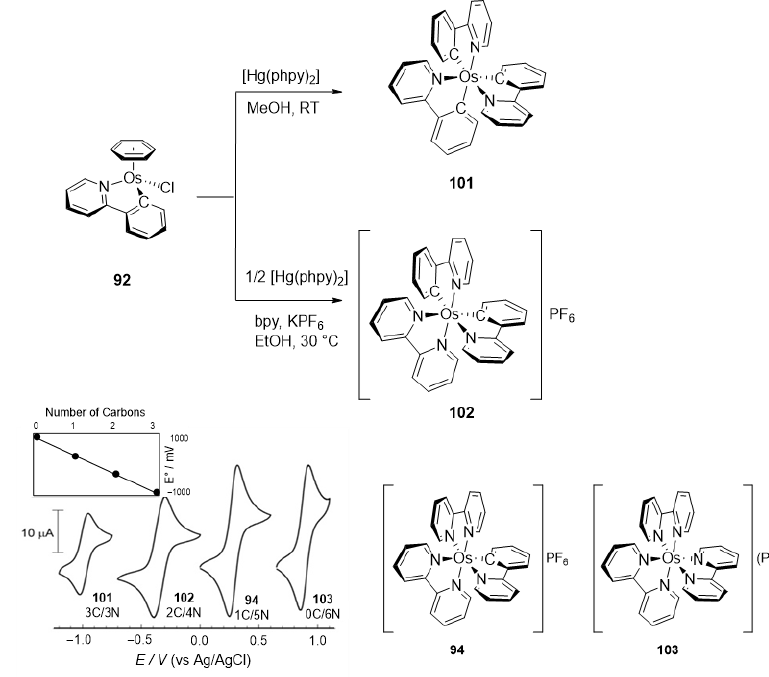
Figure 21. Synthesis of bis - and tris -cyclometalated complexes (top) and cyclic voltammograms showing the influence of the number of Os − C bonds on the Os II /Os III reduction potentials). Bottom: cyclic voltammograms of 103 , 94 , 101 and 102 (1 mM) in MeCN: 25 °C, scan rate 0.1 V s − 1 , 0.1 M n Bu 4 NPF 6 , glassy carbon electrode. Inset shows a plot of the formal reduction potential vs. the number of C donors.